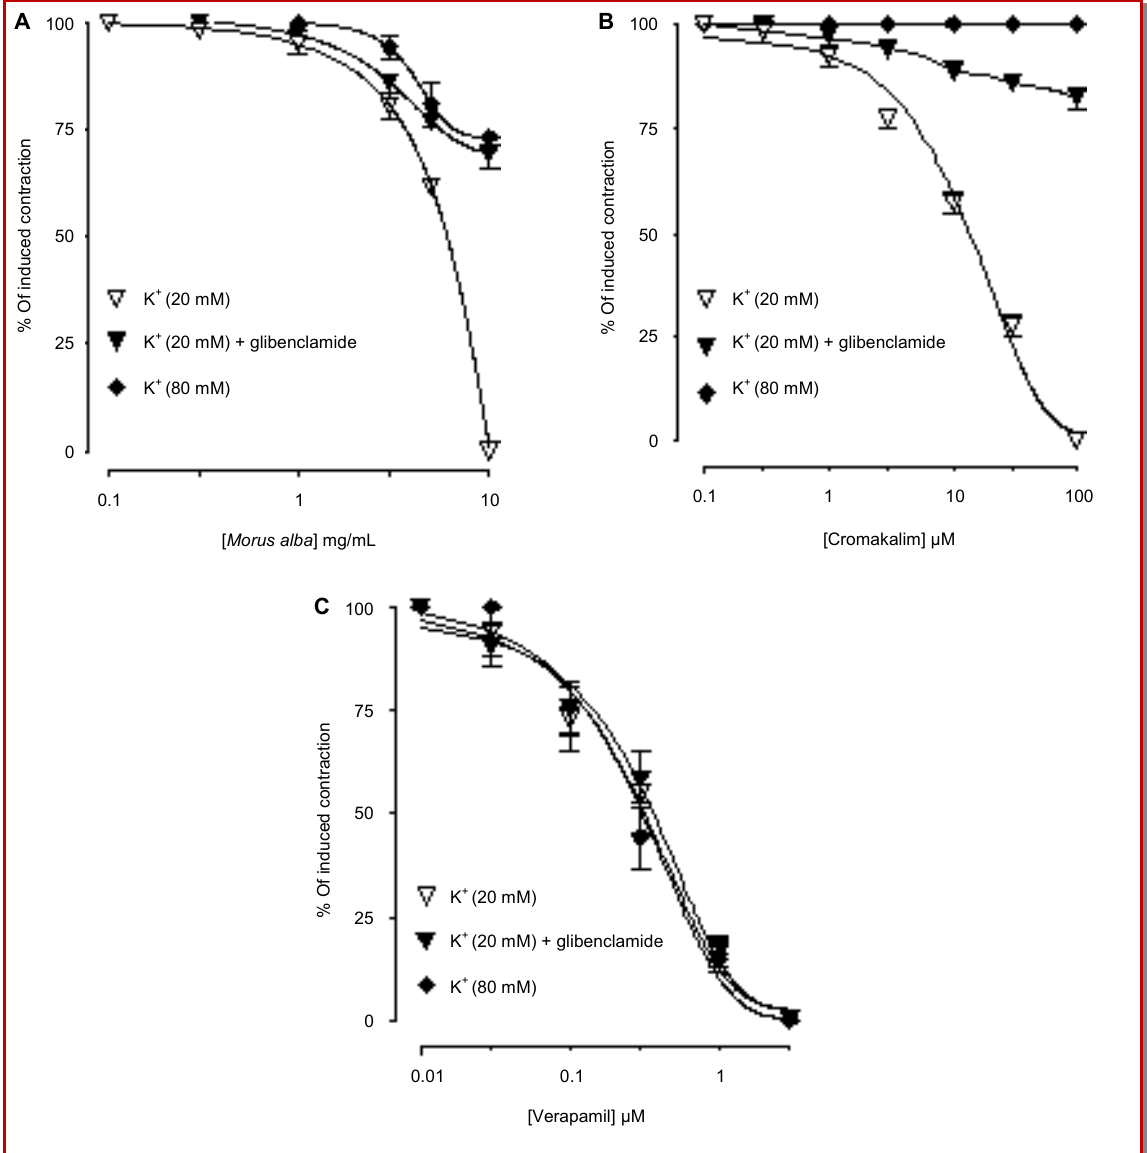
Figure 2: Concentration-response curves showing the comparison of (A) crude extract of Morus alba , (B) cromakalim and (C) vera- pamil for the inhibitory effect against low K + (20 mM) in the absence and presence of glibenclamide (3 µM) and high K + (80 mM)- induced contractions in isolated rabbit jejunum preparations. Values shown are mean ± SEM, n =